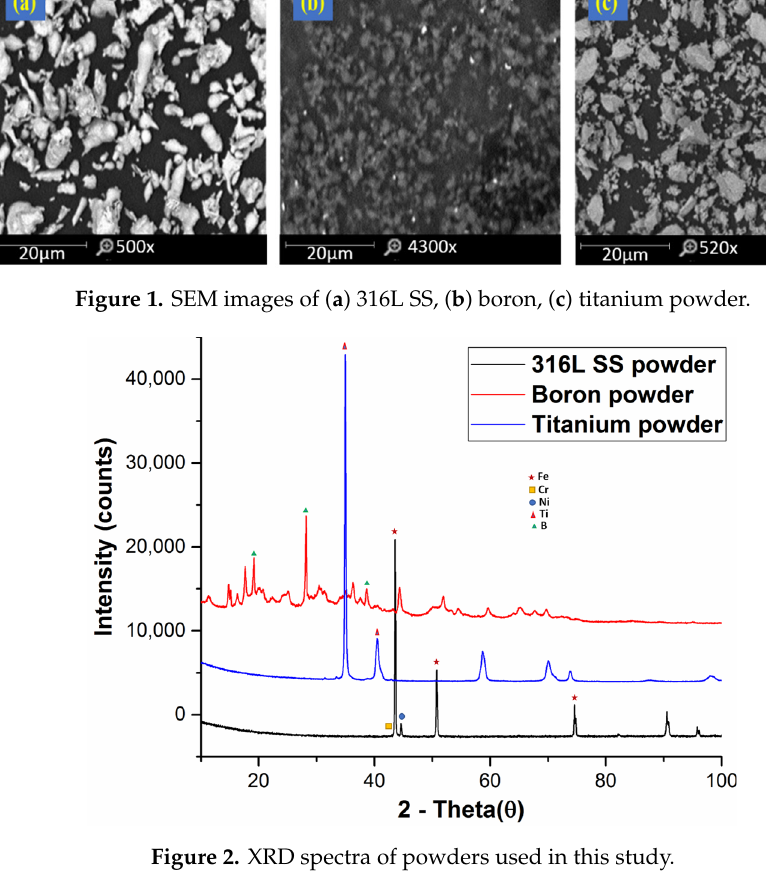
Figure 2. XRD spectra of powders used in this study.